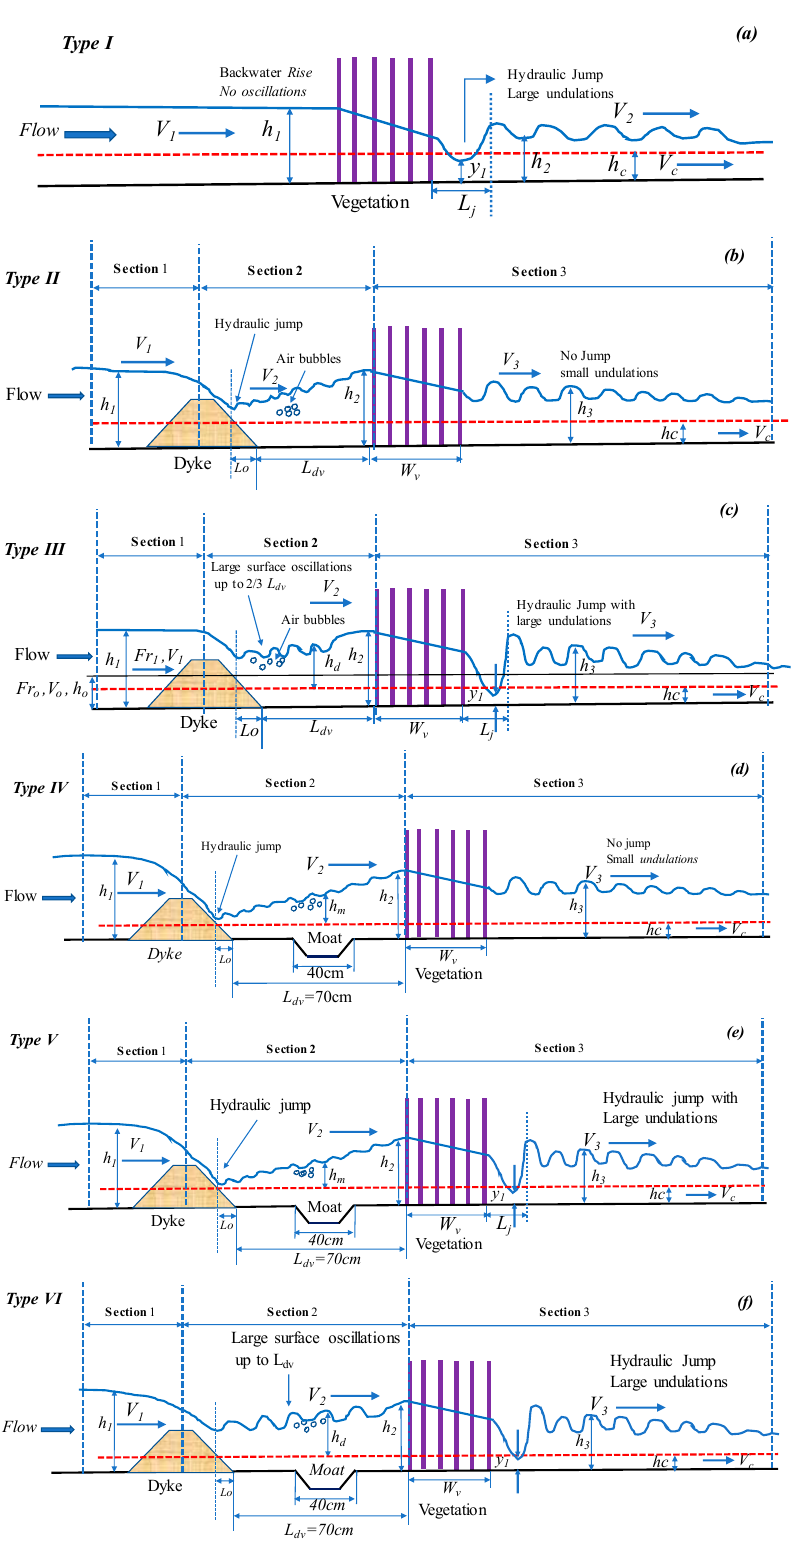
Figure 6. Hydraulic jump and water surface classifications: (OV model: ( a ) Jump on the downstream of vegetation (Type I)), (DV model: ( b ) Jump in Section 2 only (Type II) ( c ) Jump in Section 3 only (Type III)), (DVM model: ( d ) Jump in Section 2 only (Type IV) ( e ) Jump in both Sections 2 and 3 (Type V)) ( f ) Jump in Section 3 only (Type VI).